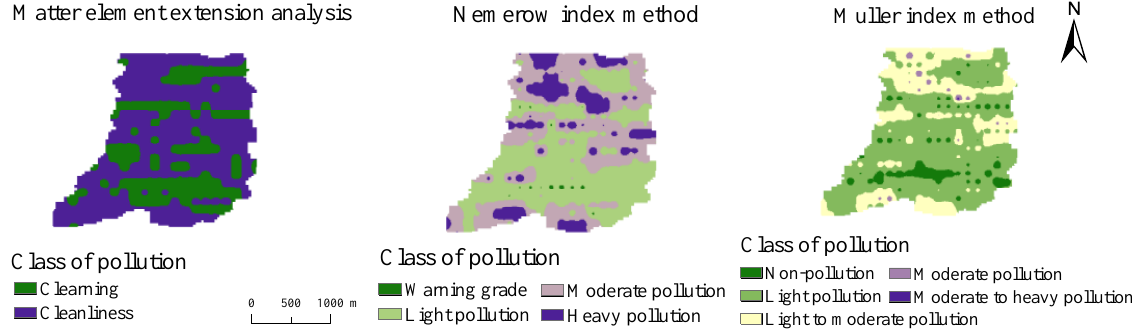
Figure 4. Spatial distribution of assessment grades of potential toxic elements contamination in topsoil in the study area.